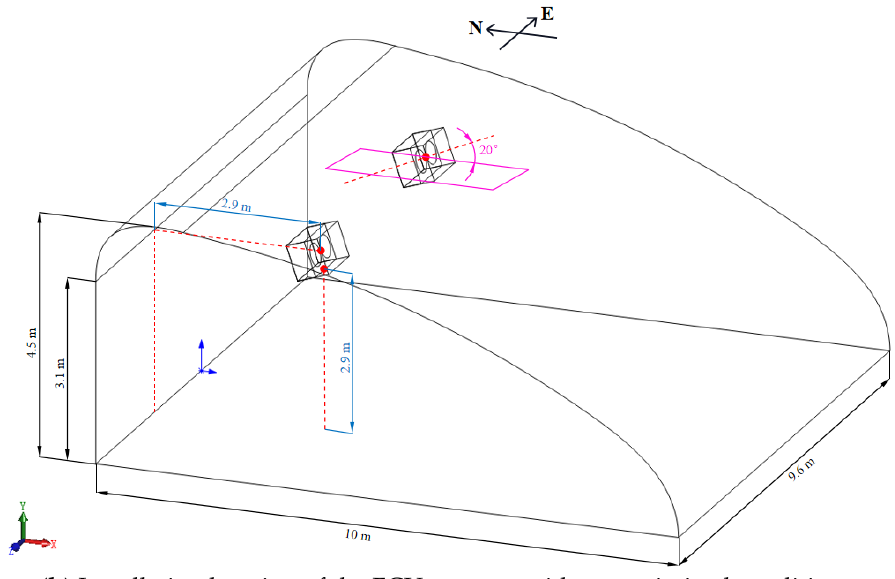
Figure 3. Schematic diagrams of the greenhouse incorporating two identical FCU systems.